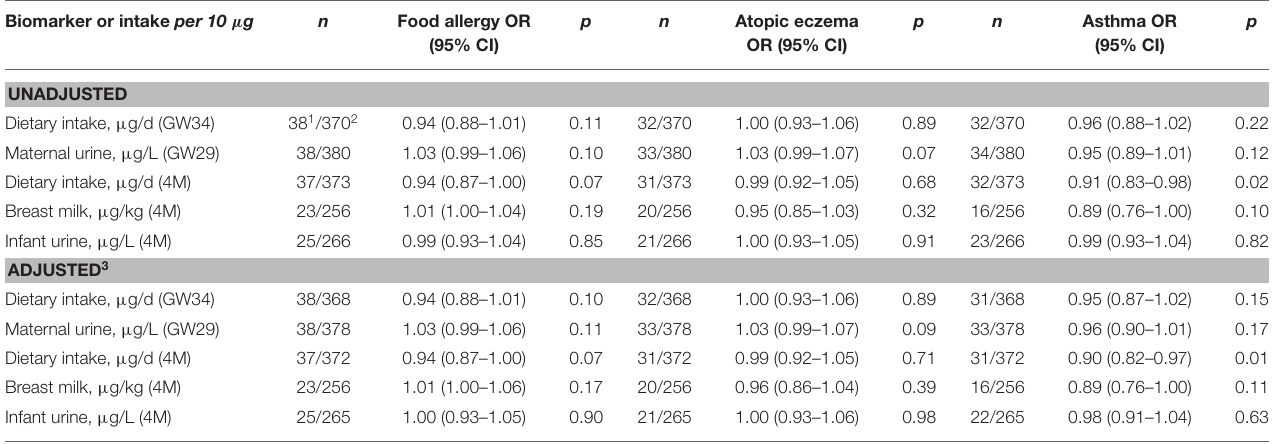
TABLE 5 | Logistic regression analyses of iodine status with infant allergy diagnosis at 12 months of age. Biomarker or intake per 10 µ g